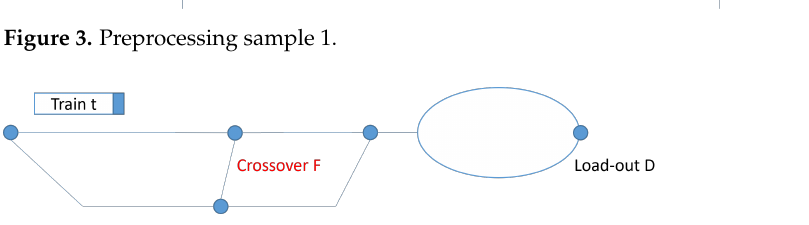
Figure 4. Preprocessing sample